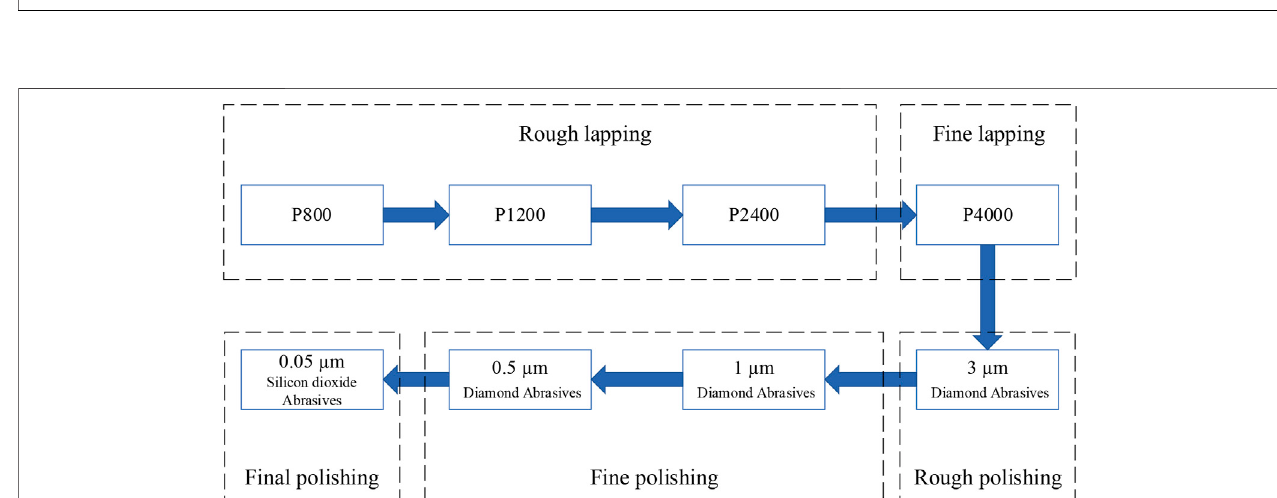
FIGURE 1 | Automatic lapping and polishing machine.